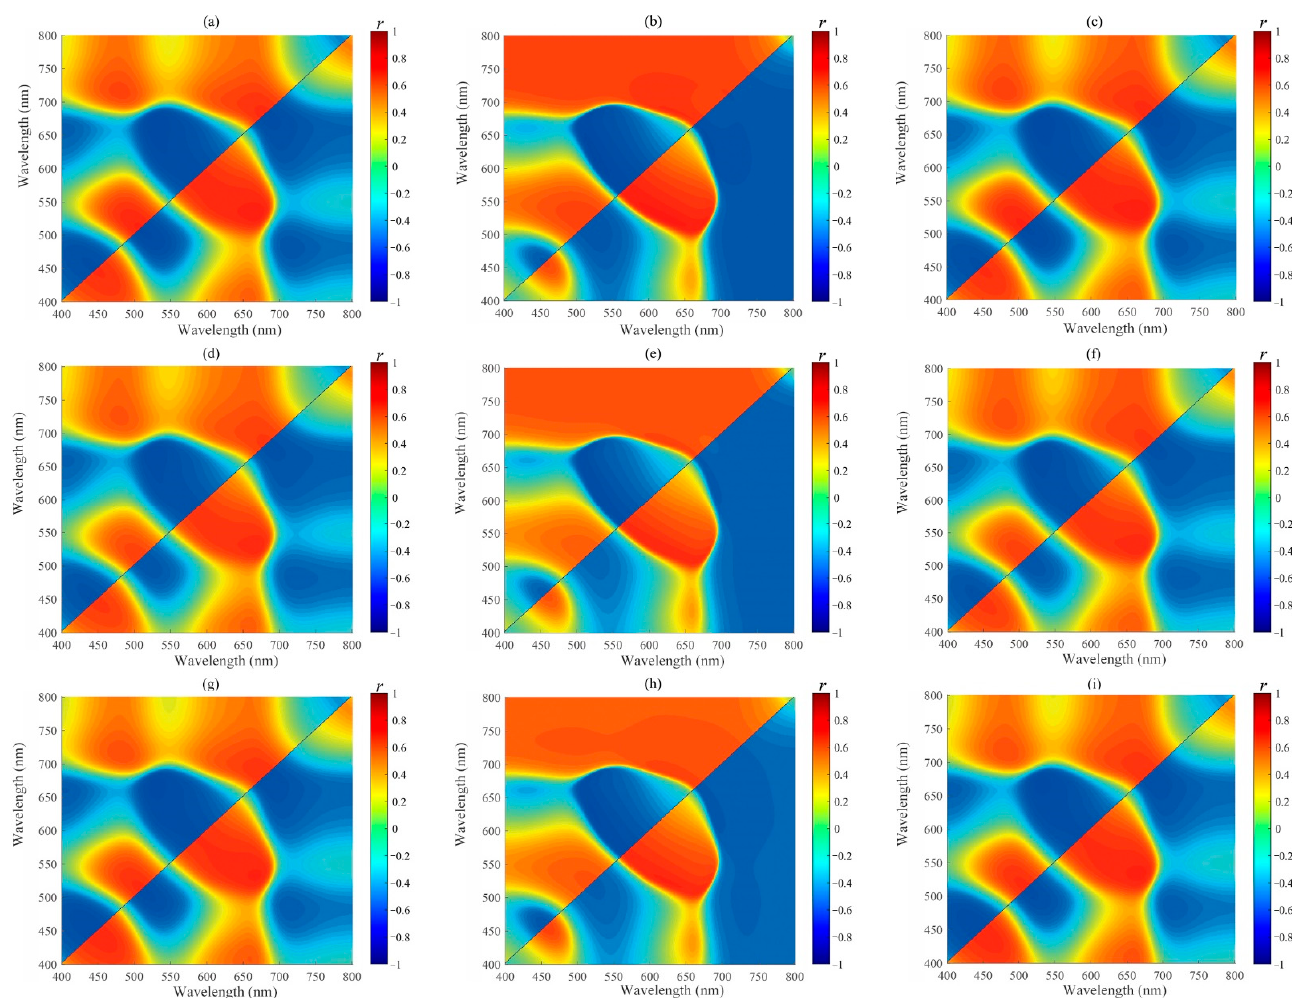
Figure 5. Coefficients of correlation between PhiPS2, Fv'/ Fm' , and qP with RVI ( λ 1, λ 2), NDVI ( λ 1, λ 2), DVI ( λ 1, λ 2), and ratio/normalized difference/difference vegetation indexes constructed from raw spectral data. ( a ) Correlation between PhiPS2 and RVI (RVI band combinations based on the raw reflectance relationship with EWT); ( b ) Correlation between PhiPS2 and DVI; ( c ) Correlation between PhiPS2 and NDVI; ( d ) Correlation between Fv'/ Fm' and RVI; ( e ) Correlation between Fv'/ Fm' and DVI; ( f ) Correlation between Fv'/ Fm' and NDVI; ( g ) Correlation between qP and RVI; ( h ) Correlation between qP and DVI; and ( i ) Correlation between qP and NDVI.